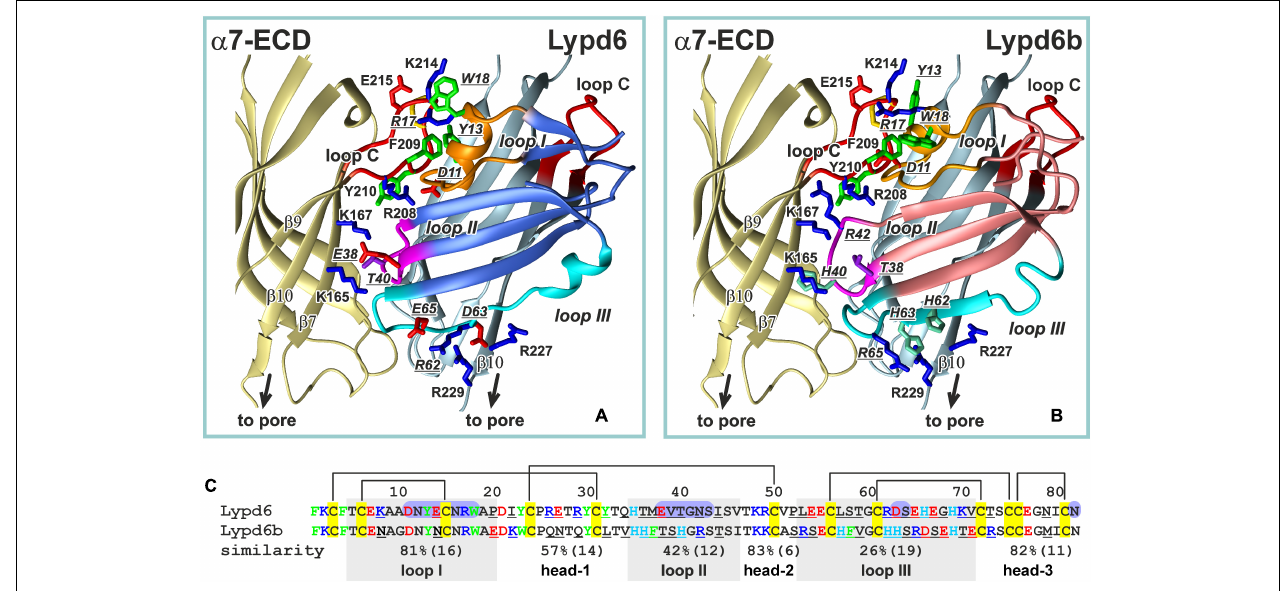
FIGURE 9 | Comparison of the ws-Lypd6 and ws-Lypd6b amino acid sequences and their possible complexes with α 7-ECD. (A) The “favorable” contacts in the α 7-ECD/ws-Lypd6 complex ( Figure 8C ). The sidechains participating in the electrostatic and hydrophobic interactions are shown. (B) The possible structure of the α 7-ECD/ws-Lypd6b complex. The ws-Lypd6b molecule is shown in the same orientation as ws-Lypd6 molecule in (A). Ws-Lypd6b cannot form as many “favorable” contacts with the receptor as ws-Lypd6. (C) Sequence alignment of the LU-domains of ws-Lypd6 and ws-Lypd6b. The similarity (%) is independently shown for each region of the proteins. The total number of residues in the loops is given in brackets. The differing residues are underlined. The aromatic (Phe, Trp, Tyr), positively charged (Arg and Lys), negatively charged (Asp and Glu), and His residues are colored in green, blue, red, and cyan, respectively. The residues of ws-Lypd6 forming contacts with α 7-ECD in the proposed model are highlighted by violet background.